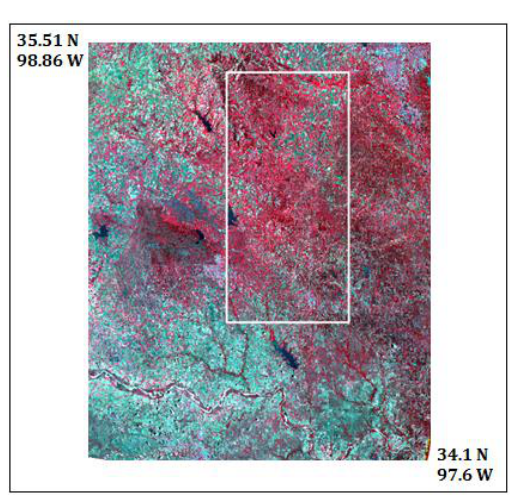
Figure 1. Landsat-5 TM image showing the general locations of the study